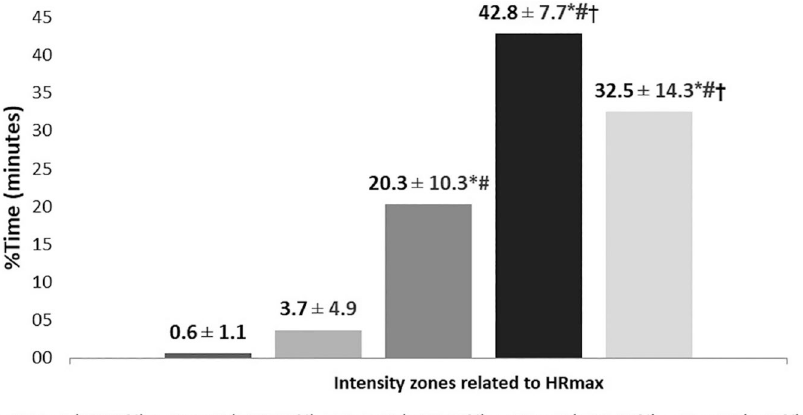
Figure 1 - Time percentage spent in intensities effort zones relative to HR max , during the TF session (n = 12). F = 48.6. ∗ p < 0.05 in relation to zone 1; #p < 0.05 in relation to zone 2; † p < 0.05 in relation to zone 3.